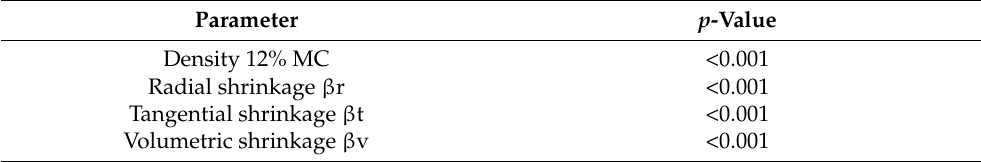
Table 4. t -test for independent samples results compared between heat-treated and untreated wood [8]. Parameter p -Value Density 12% MC <0.001 Radial shrinkage β r <0.001 Tangential shrinkage β t <0.001 Volumetric shrinkage β v